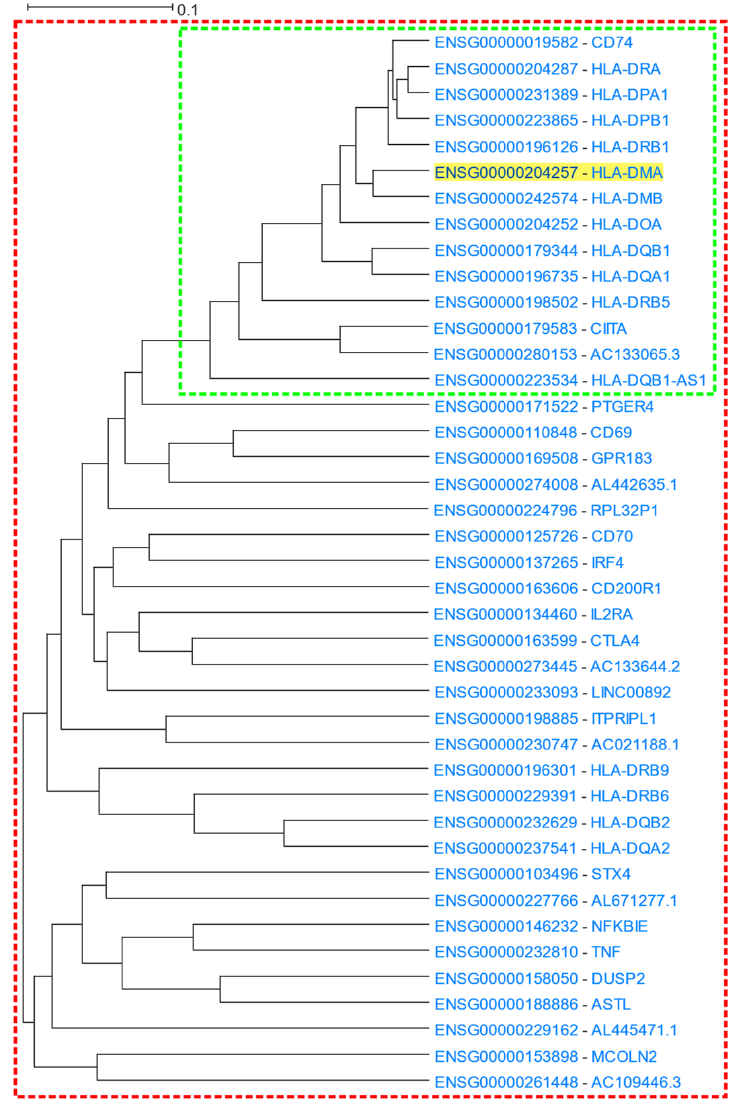
Figure 4. HGCA2.0 HLA-DMA coexpression clade. The 7 internal node clade is included in the green box, while the expanded 14 internal node clade is included in the red box.